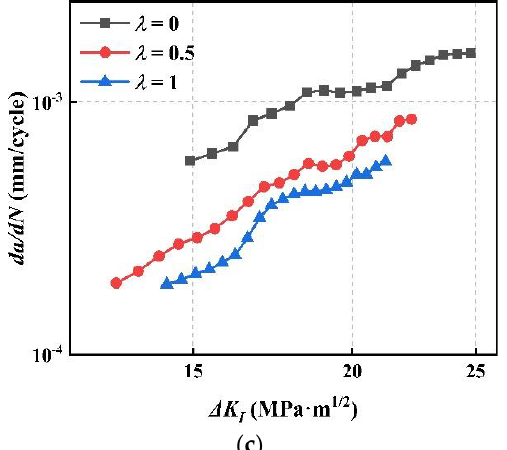
Figure 13. Where β = 45°, the relationship between FCGR and ∆ K I under different stress ratios ( a ) R = 0 ( b ) R = 0.1 ( c ) R = 0.3.